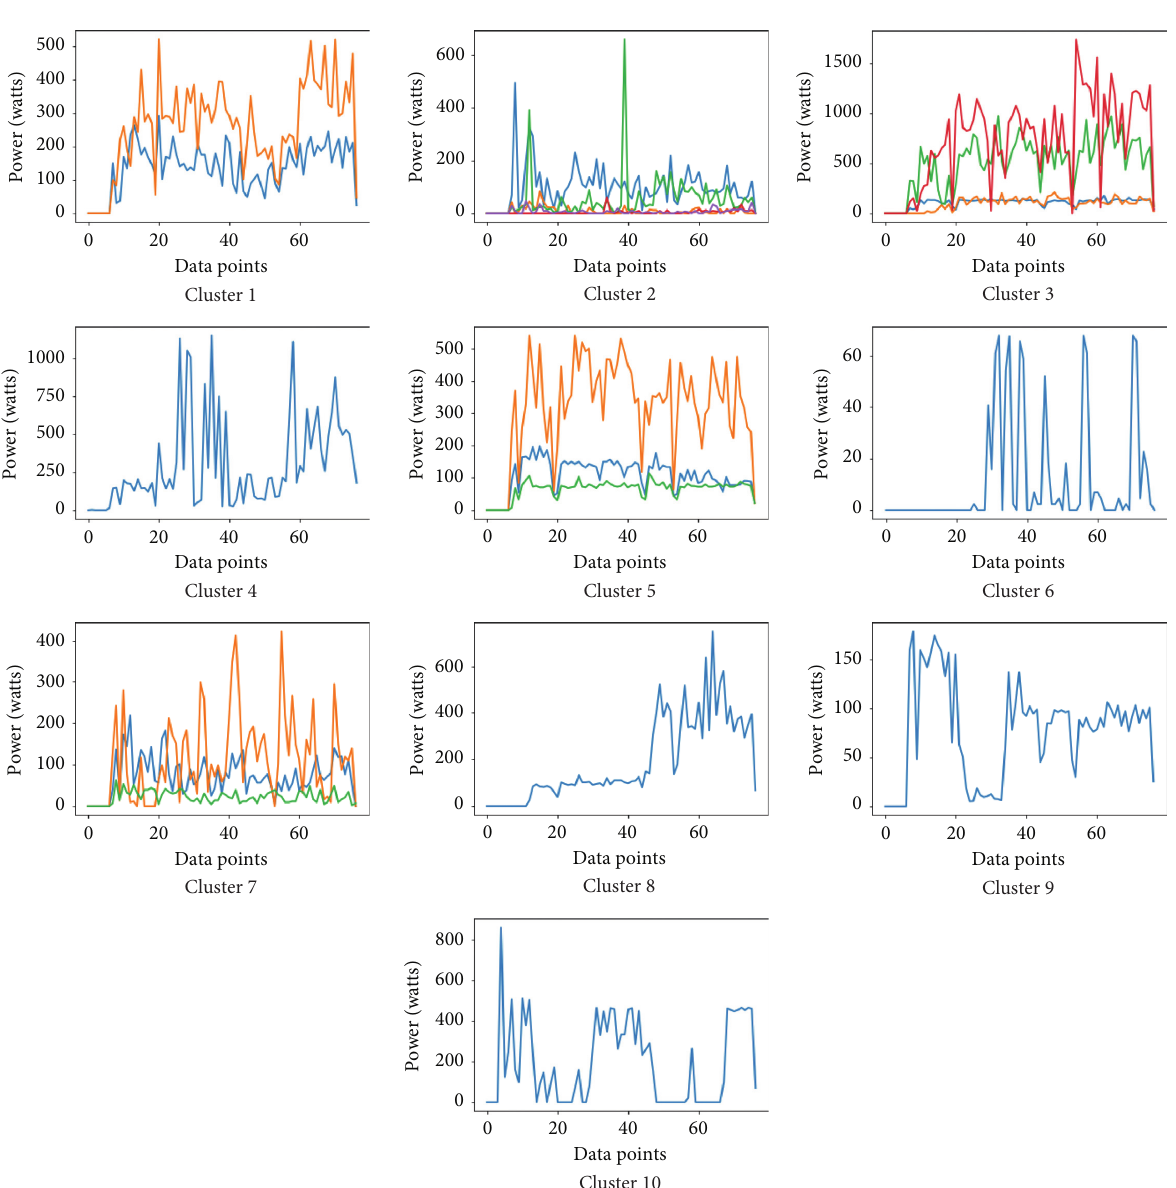
Figure 9: Different clusters obtained after the K-means clustering algorithm.